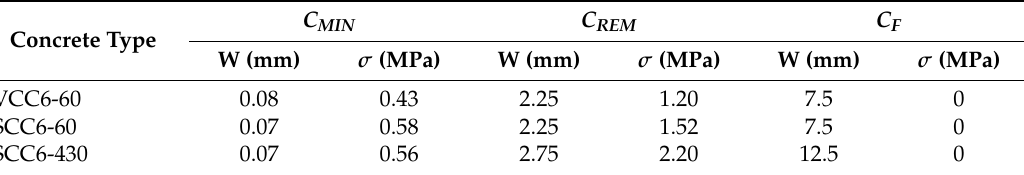
Figure 11. Softening functions implemented. Table 4. Turning points for the numerical simulation.